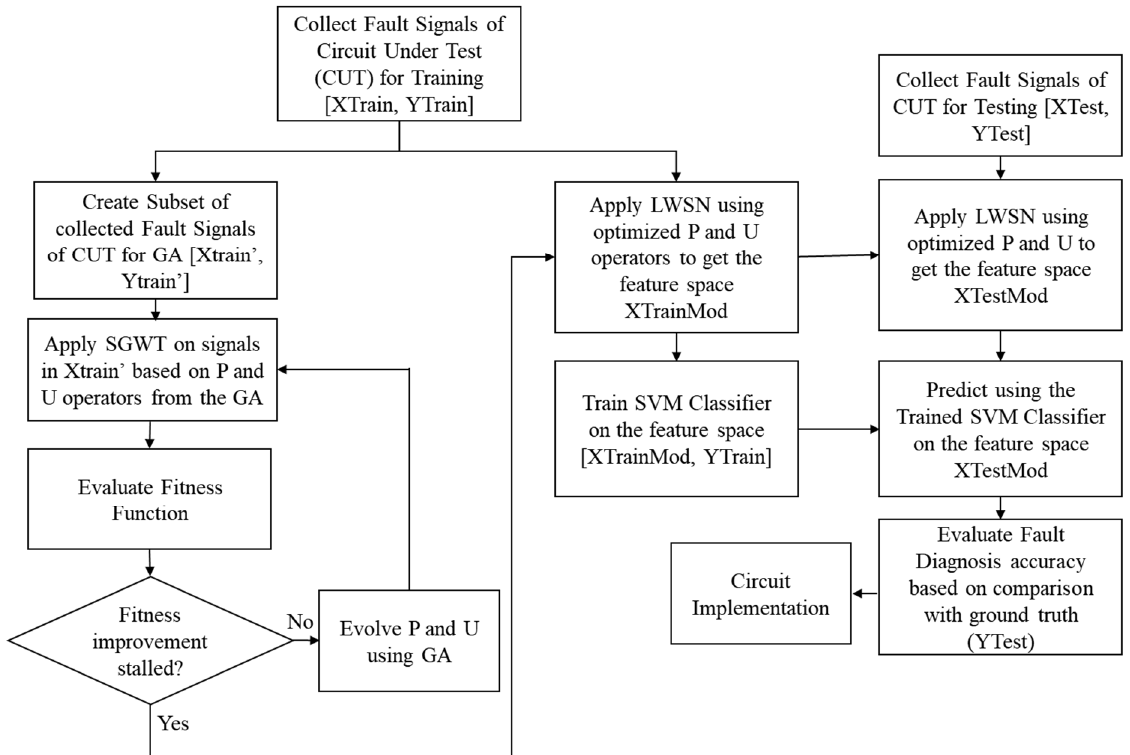
Figure 3. Fault diagnosis methodology.